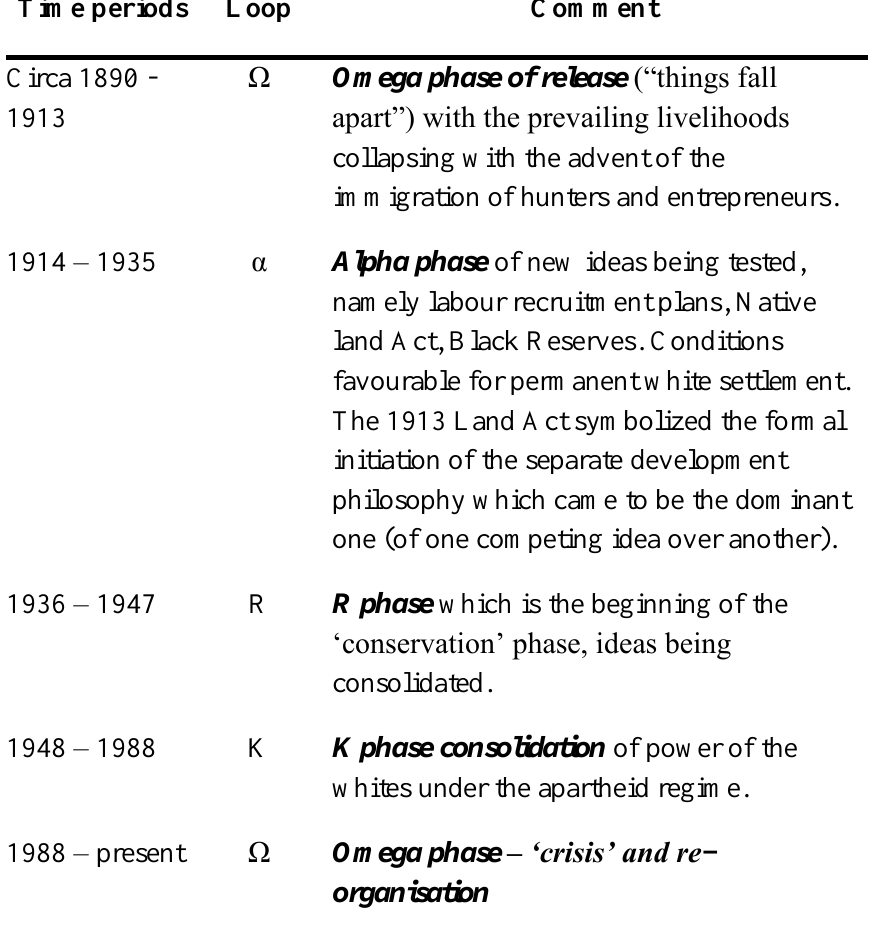
Table A2.1. Interpretation of political drivers in the Sand River Catchment over the last 100 years using the framework of GAC (Holling 2000, Gunderson and Holling 2002). Note that these interpretations are those of the authors which were reviewed by the specialist group and regarded as reasonable given (a) the clear development of generally recognized phases in the historical timeline (Appendix 3), and (b) the scale at which the interpretations were made. An evaluation of the GAC framework is given in the